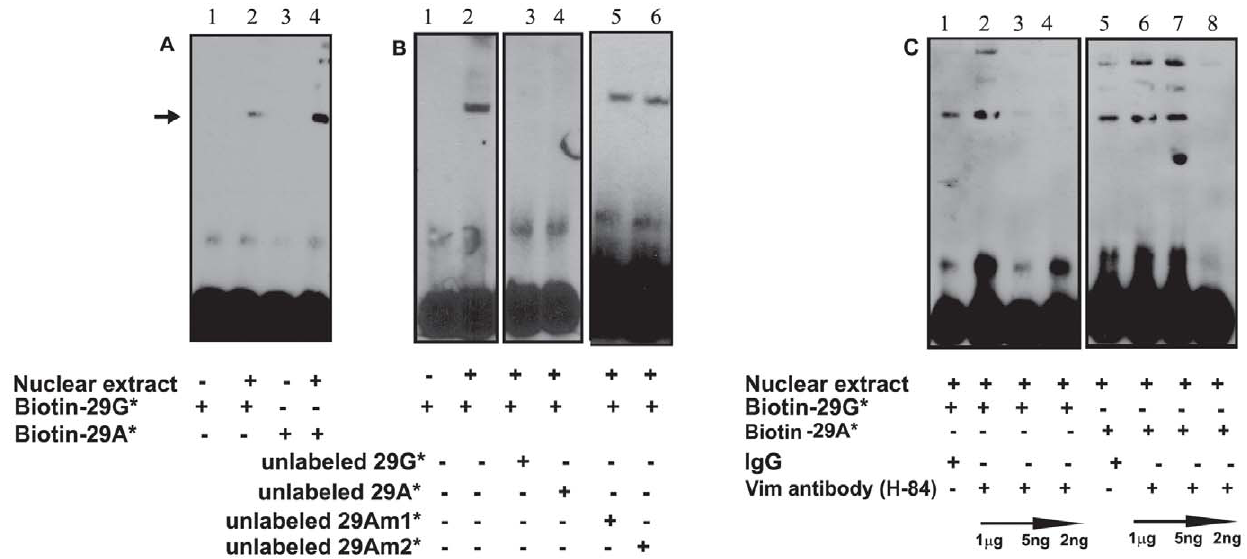
Figure 3. Specific invitro Binding of Vimentin to Promoter Variants. ( A ) Biotin-labeled duplex oligos and 10 m g NIH3T3 nuclear extract were used for the experiments. Arrow indicates protein binding to the oligos. ( B ) Determination of specificity of duplex 29G* by completion with unlabeled duplex oligos. ( C ) Specific binding of vimentin to 29G* and 29A* oligos was demonstrated with anti-vimentin antibody.